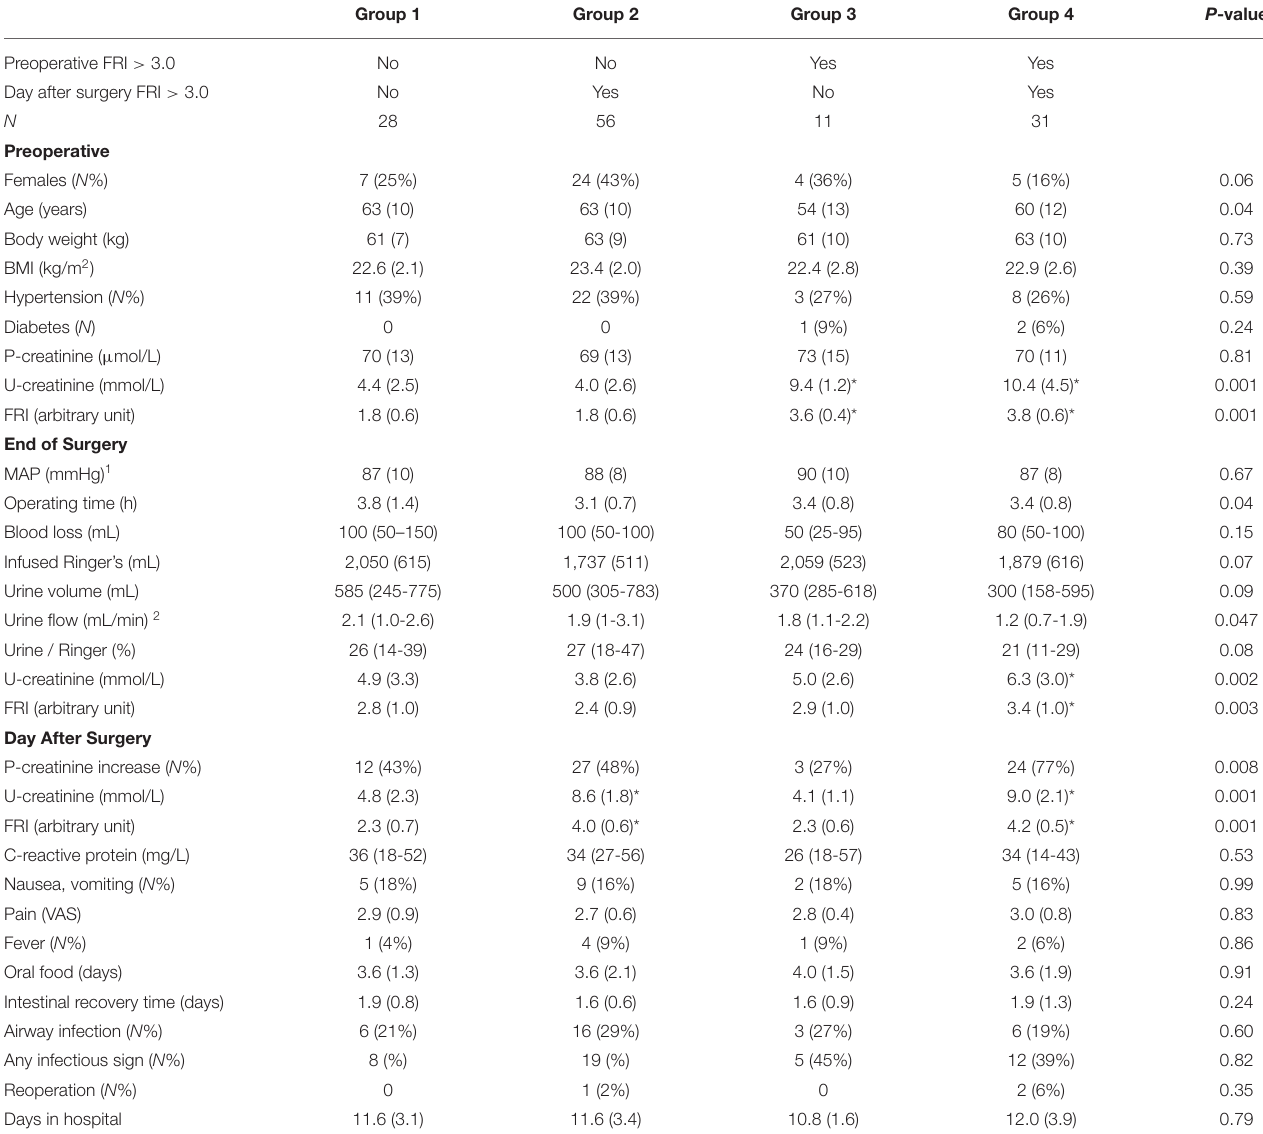
TABLE 2 | Key data based on whether the urinary Fluid Retention Index (FRI) just before surgery and on the 1st postoperative day was > 3.0 or not. Group 1 Group 2 Group 3 Group 4 P -value Preoperative FRI > 3.0